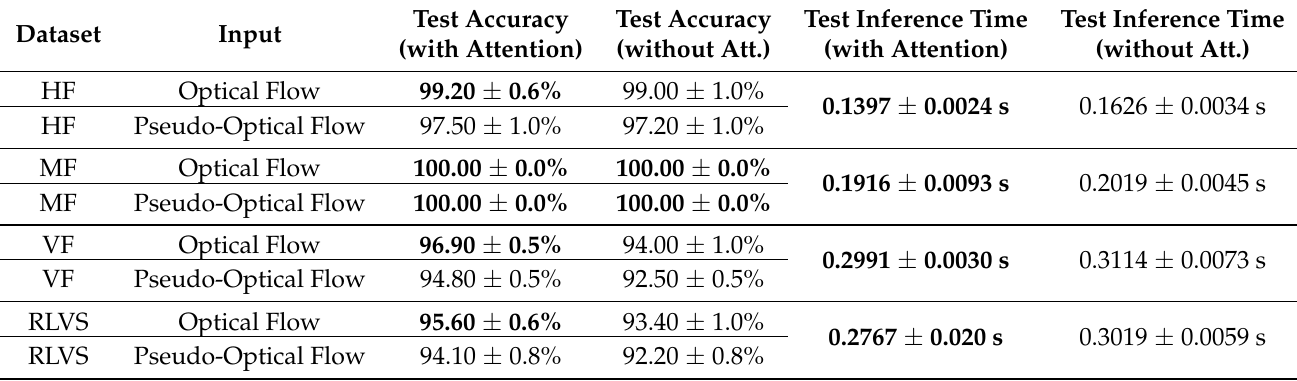
Table 2. Ablation study of architecture Bi-Dense attention and Bi-Dense without